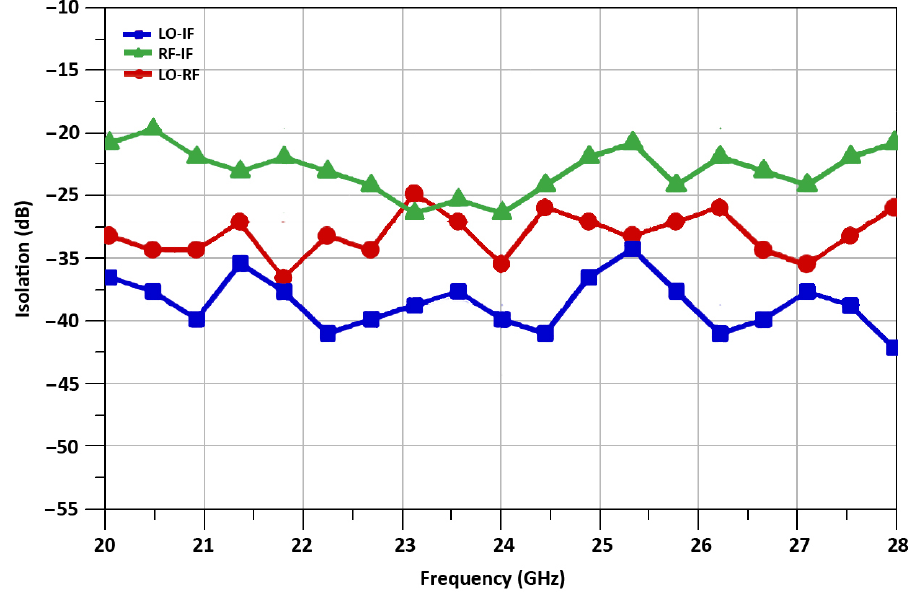
Figure 17. Isolations between mixer’s ports. The proposed mixer’s conversion gain is simulated and measured for 24 GHz up- converted RF frequency, with the 21.6 GHz LO frequency, and 2.4 GHz IF frequency. The conversion gain increases with the increment of the LO power, but for low power operation, LO is selected to be 2 dBm. The maximum measured conversion gain at 24 GHz RF frequency is 4.1 dB. The conversion gain of a mixer is equal to 3.2 ± 0.9 dB, versus frequency from 20 to 30 GHz is illustrated in Figure 18, while conversion gain versus LO power from − 8 dBm to 8 dBm is shown in Figure 19.